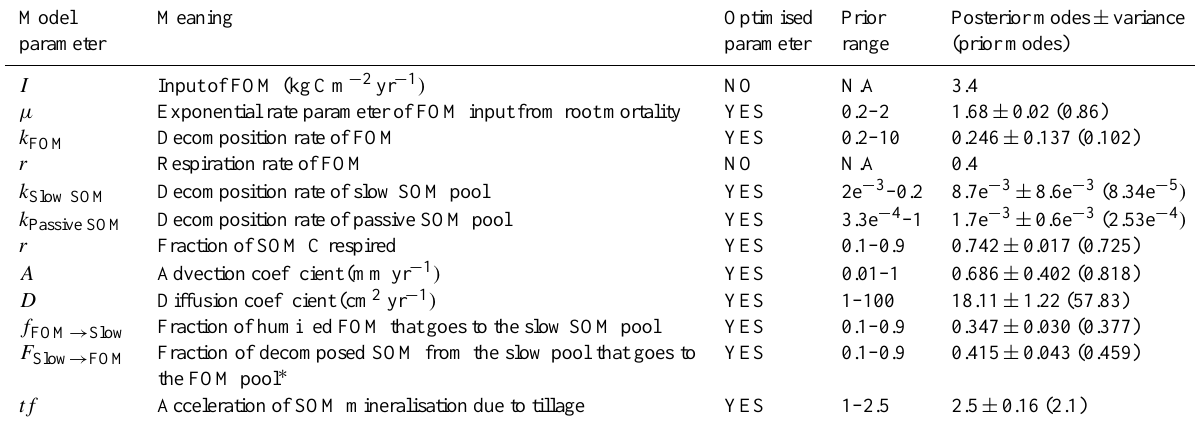
Table 2. Model parameters summary for the model MIN3- T AD . Model Meaning Optimised Prior Posterior modes ± variance parameter parameter range (prior modes) Exponential rate parameter of FOM input from root